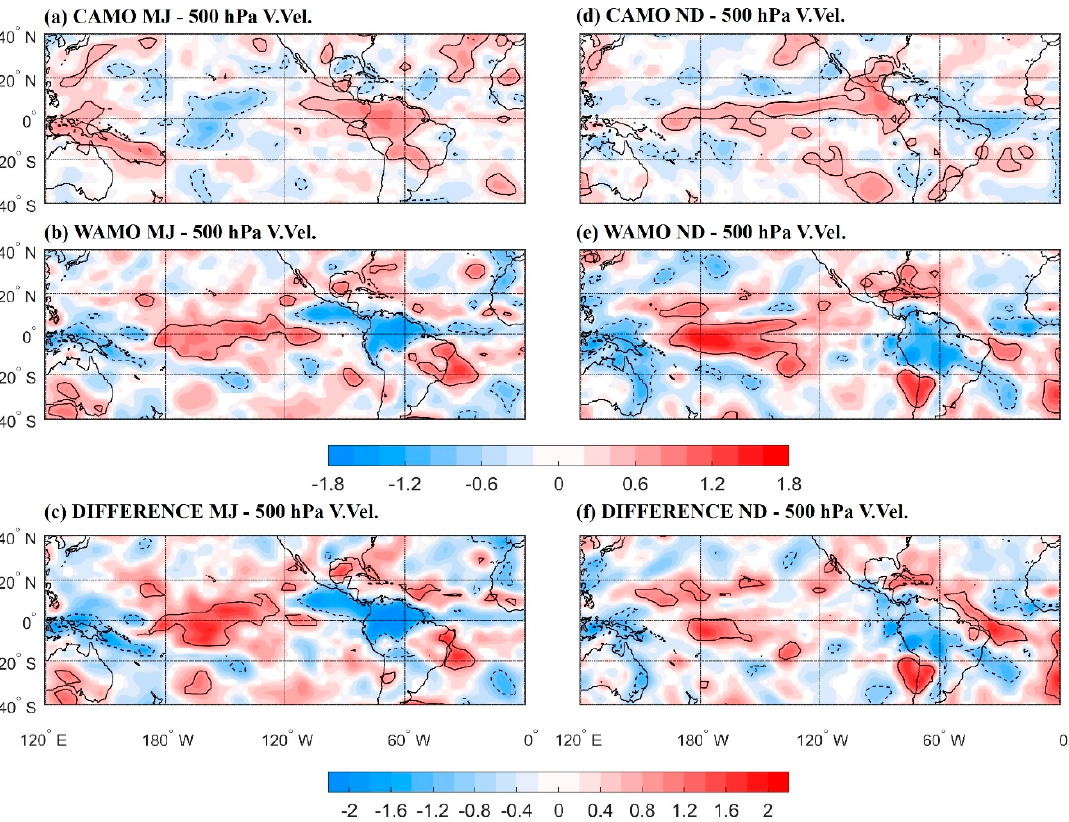
Figure 6. MJ standardized anomaly patterns associated with extreme flow events at Bellavista (left column) for the 500 hPa vertical velocity in pressure coordinates during ( a ) CAMO, ( b ) WAMO, and ( c ) WAMO minus CAMO. ND standardized anomaly patterns associated with extreme flow events at Bellavista (right column) for the 500 hPa vertical velocity in pressure coordinates during ( d ) CAMO, ( e ) WAMO, and ( f ) WAMO minus CAMO. The contour range is 0.2 standard deviations. Shaded areas in red (blue) indicate positive (negative) values. The continuous (dashed) line encompasses significant positive (negative) values at the confidence level of 95%.